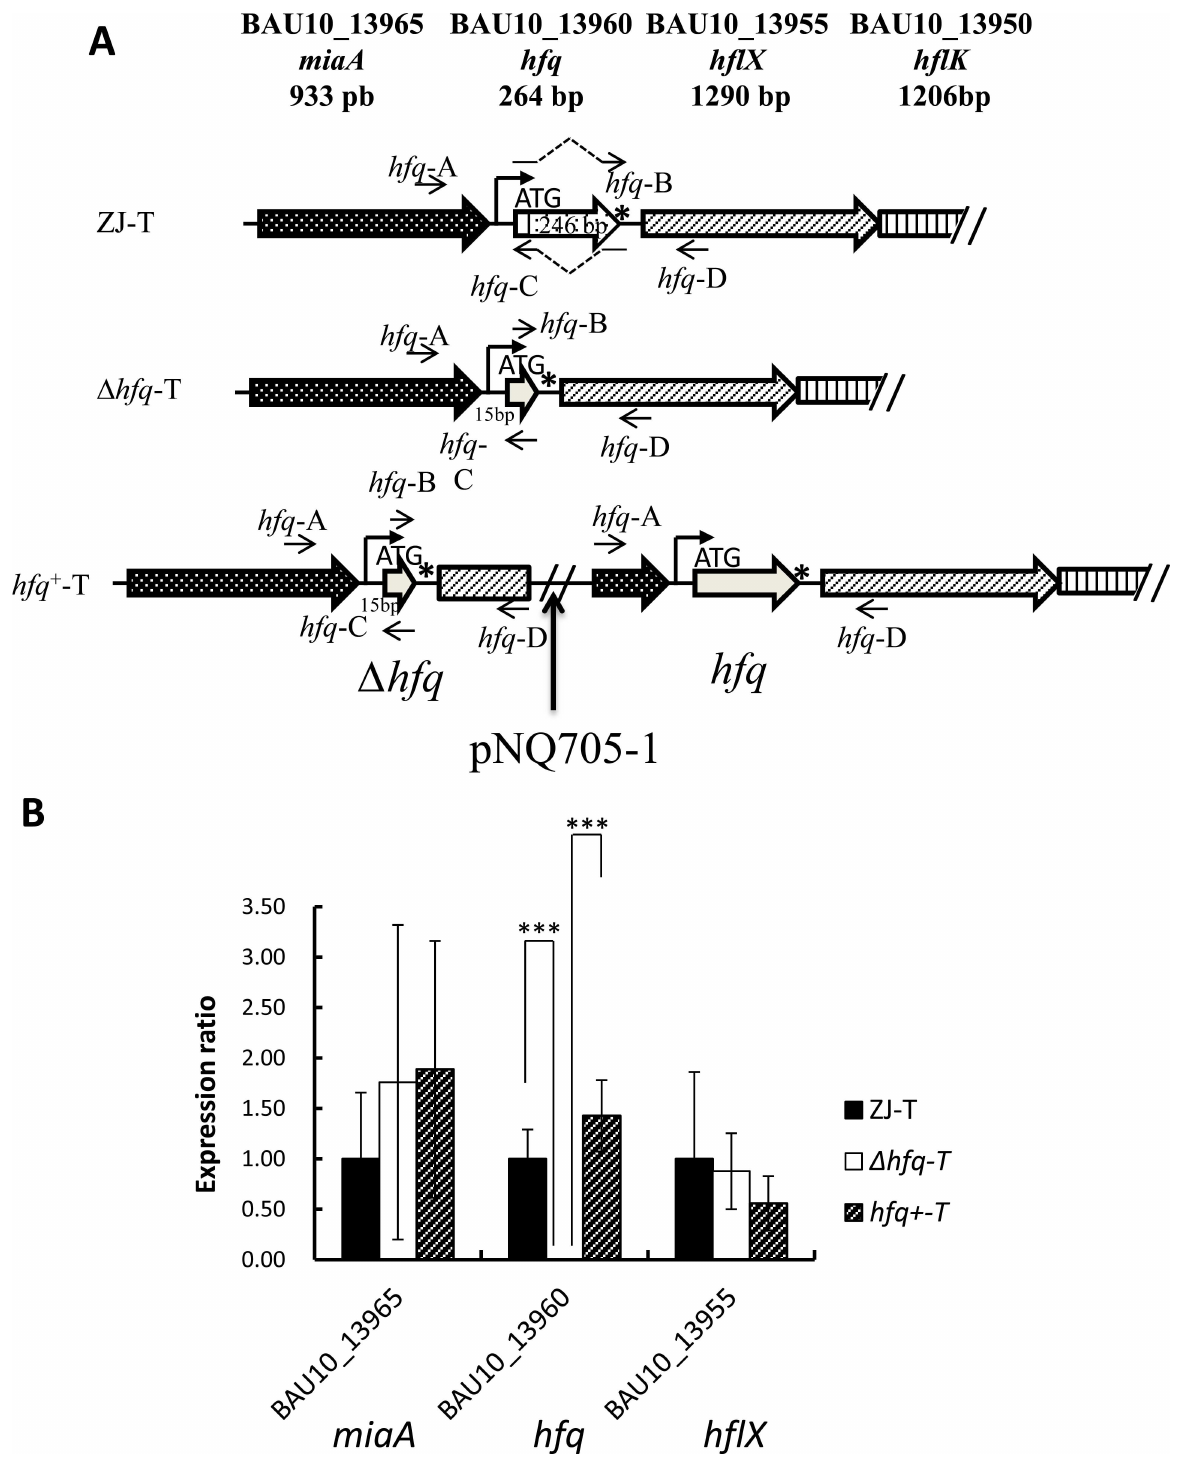
Fig 1. Structure of the hfq locus (A) and neighboring gene expression in Vibrio alginolyticus ZJ-T and derivative strains (B). A. The hfq gene is downstream of the miaA gene (locus ID = BAU10_13965) and upstream of 3 genes ( hflX , K , C ) likely to form an operon. A putative Sigma70 promoter identifiedupstream of hfq is indicated. 246 bps of the hfq ORF, from the 6th codon to the stop codon not included(marked by a star) were deletedas describedin Materials and Methods, givingrise to the Δ hfq -T strain. This mutation does not affect the potential promoter of the operon, neither the ribosome bindingsite of the downstream gene. A wild type